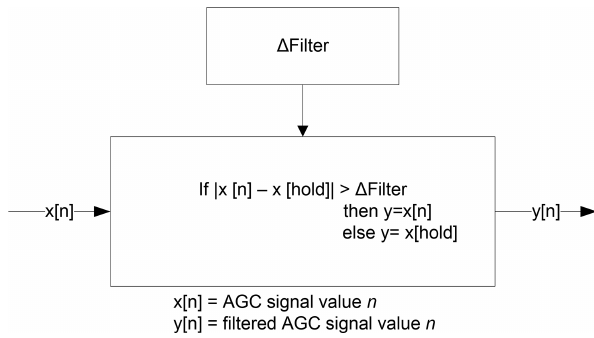
Figure 4. Differential magnitude filter logic.